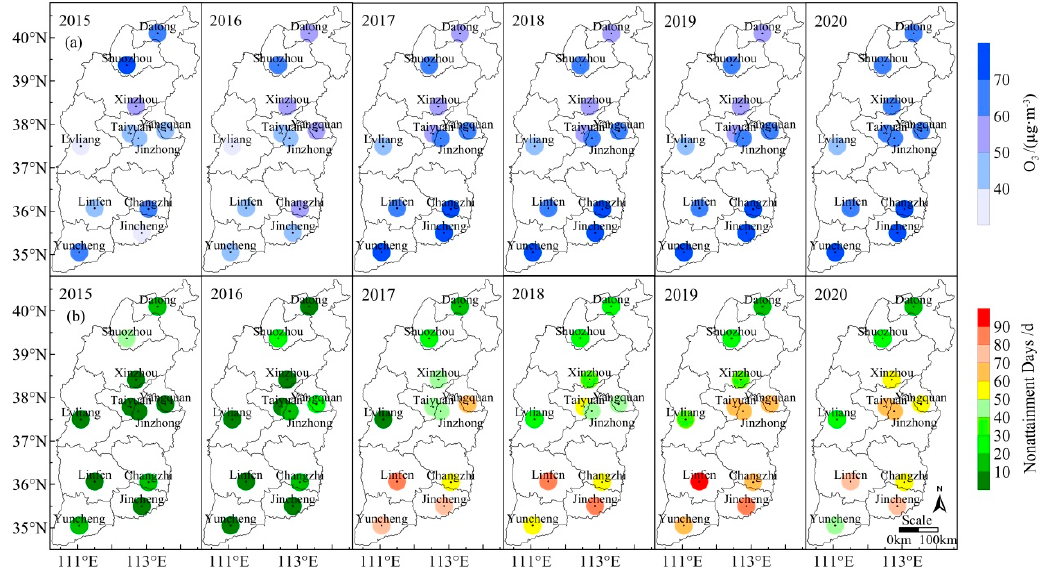
Figure 6. The spatial distribution of annual mean O 3 mass concentrations ( a ), MDA8 O 3 nonattainment days ( b ) in 11 cities of Shanxi Province during 2015 − 2020.